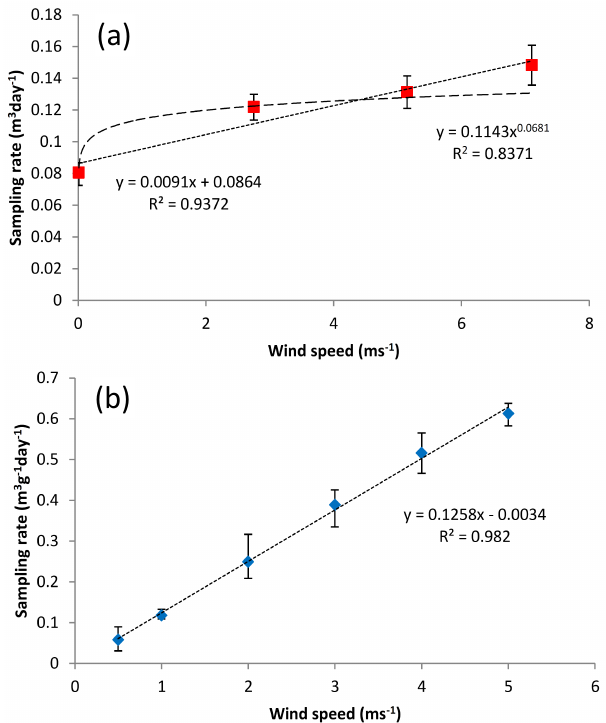
Figure 3. Wind speed dependence of SRs for GEM PASs. (a) Data from Skov et al. (2007); values are the average of 18 replicates. (b) Data from Guo et al. (2014); values are the average of five repli- cates. Data from (b) were obtained using PlotDigitizer, Free Soft- ware,